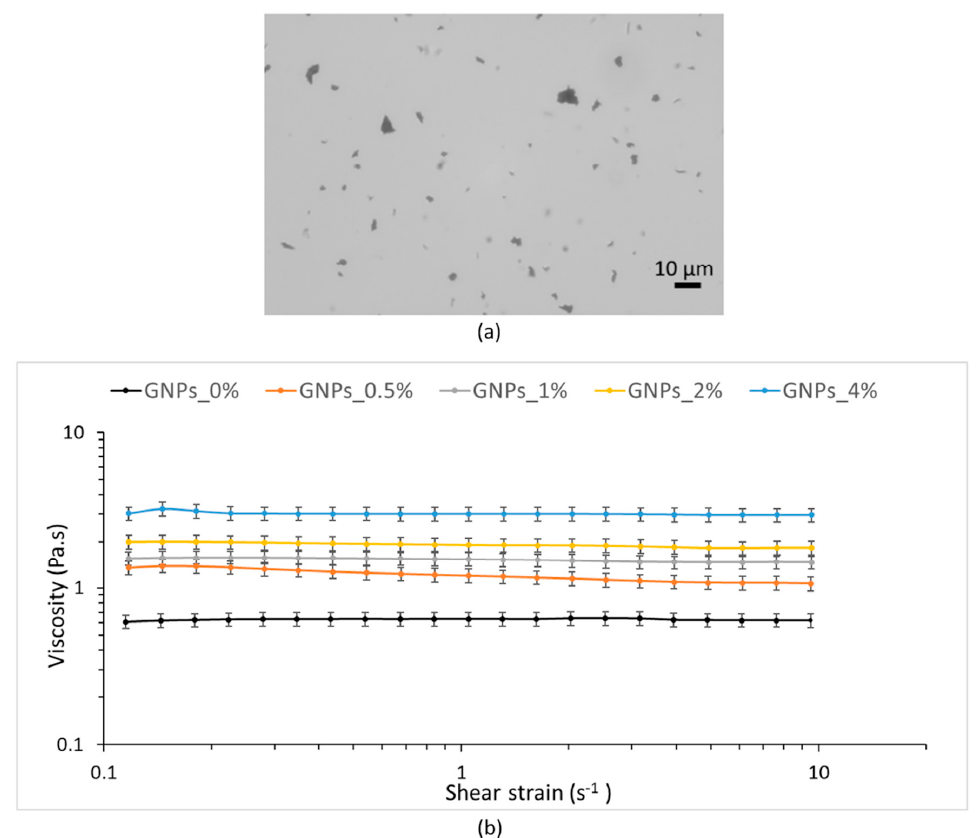
Figure 1. ( a ) Optical microscope representative image of GNPs_2%; ( b ) shear viscosity of PCL–PLA solution (GNPs_0%) and GNPs_0.5%, GNPs_1%, GNPs_2% and GNPs_4% blends in methylene chloride (MC): N,N -dimethylformamide (DMF) (70:30 v/v ).